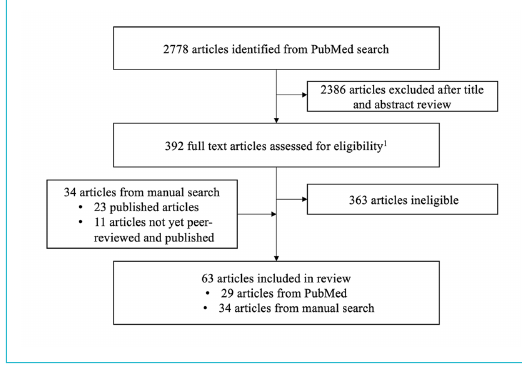
Figure 1: Study selection. 1 Eligibility: language (English, Ger- man); study design (case reports, cross-sectional studies, cohort studies, modelling studies, reviews/viewpoints; both preprints and peer-reviewed studies; study population (children and